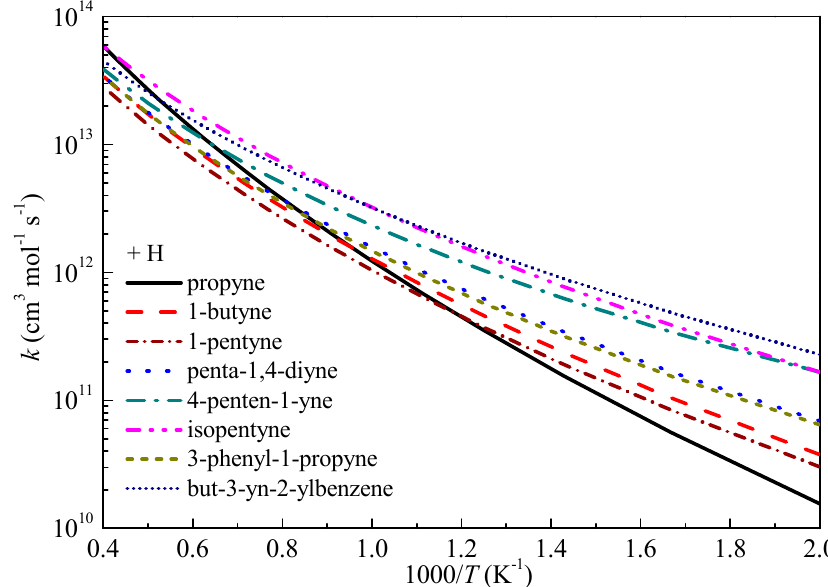
Figure 8. Computed rate constants for the abstraction reactions with H at propargyl site.